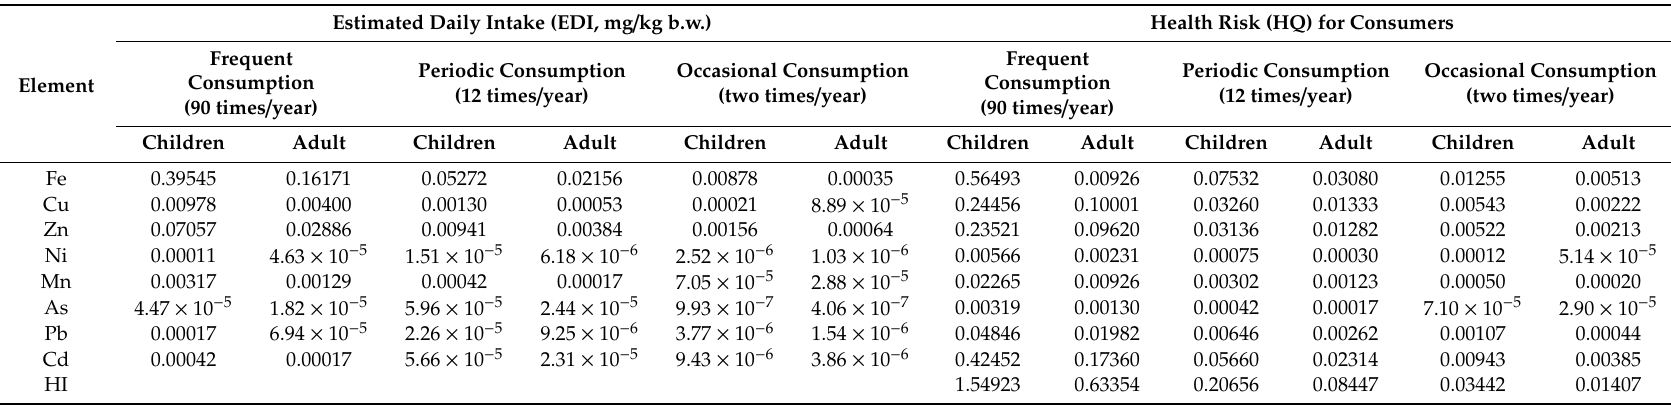
Table 6. Association of the estimated daily intake of elements, health risk (HQ), and hazard index (HI) with consumption of liver of the wild boar from group II.